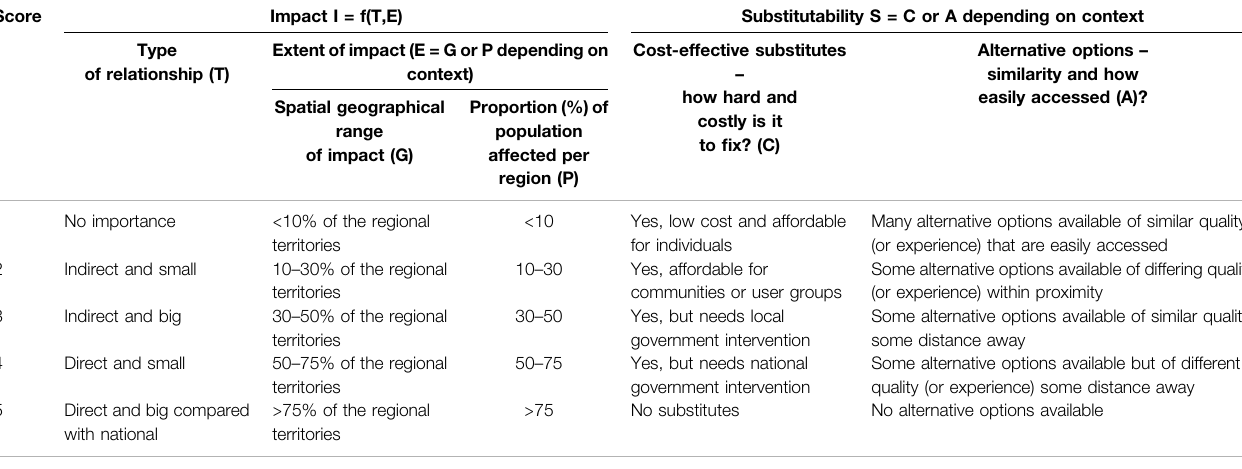
TABLE 1 | Scoring system for prioritizing the importance of each ES/NCP for each well-being domain based on the impact of an ES/NCP on a well-being domain and the substitutability of that ES/NCP for the well-being domain.